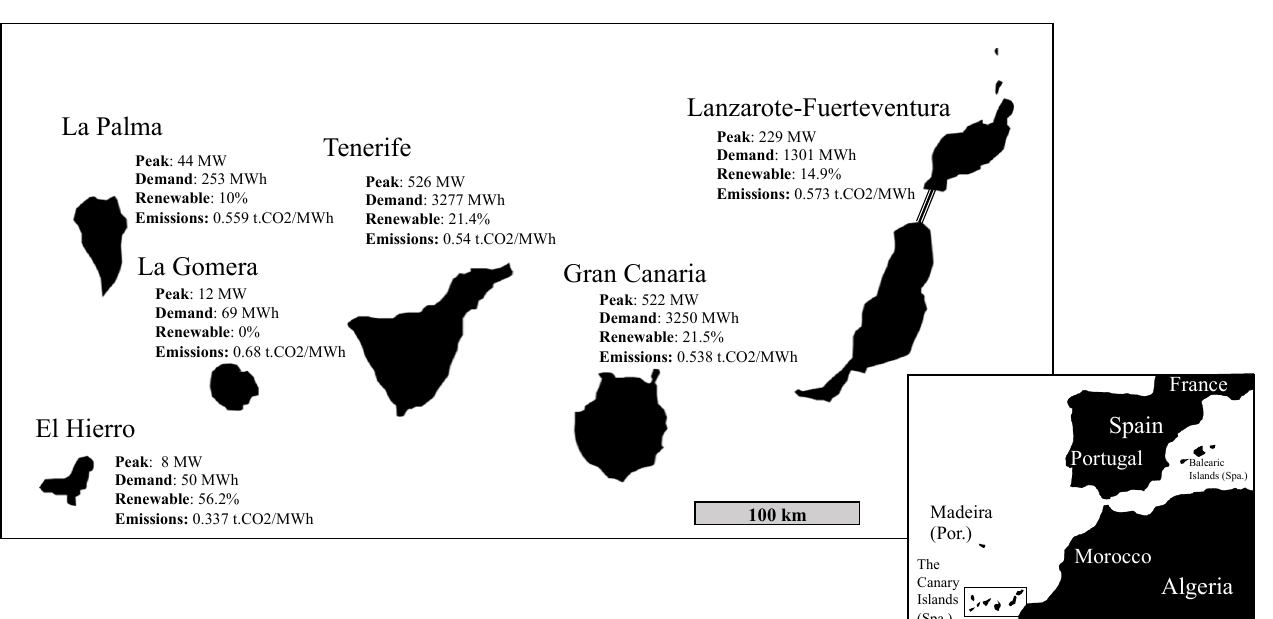
Figure 4. The features of the Canary Islands electric power systems (2021).